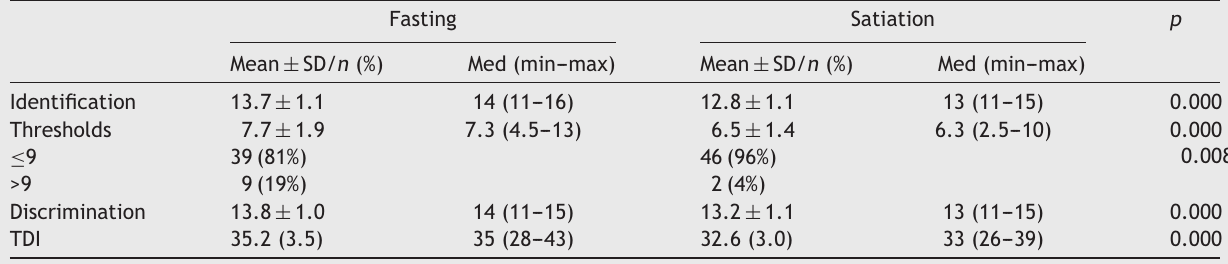
Overall olfactory function in fasting and satiation.